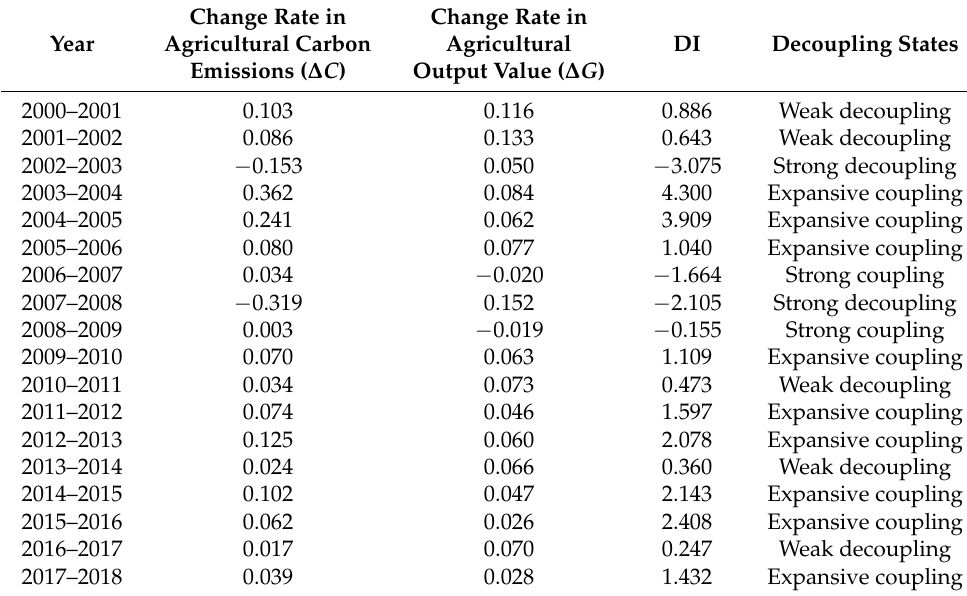
Table 7. Decoupling states in agricultural carbon emissions in Jilin province during